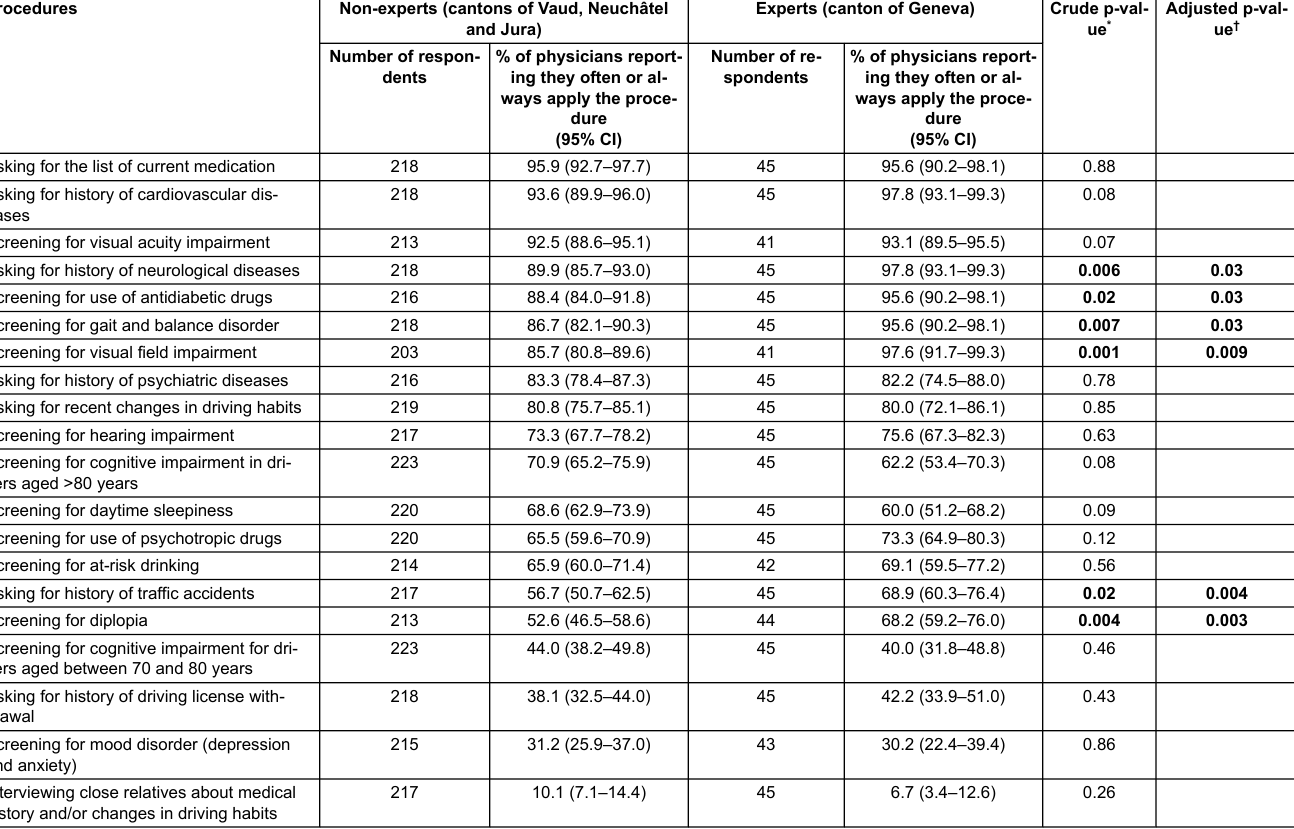
Table 4: Twenty procedures emphasised during drivers’ assessment, stratified by physicians’ canton of practice (Vaud, Neuchâtel, Jura compared with Geneva). Non-experts (cantons of Vaud, Neuchâtel Experts (canton of and Jura)